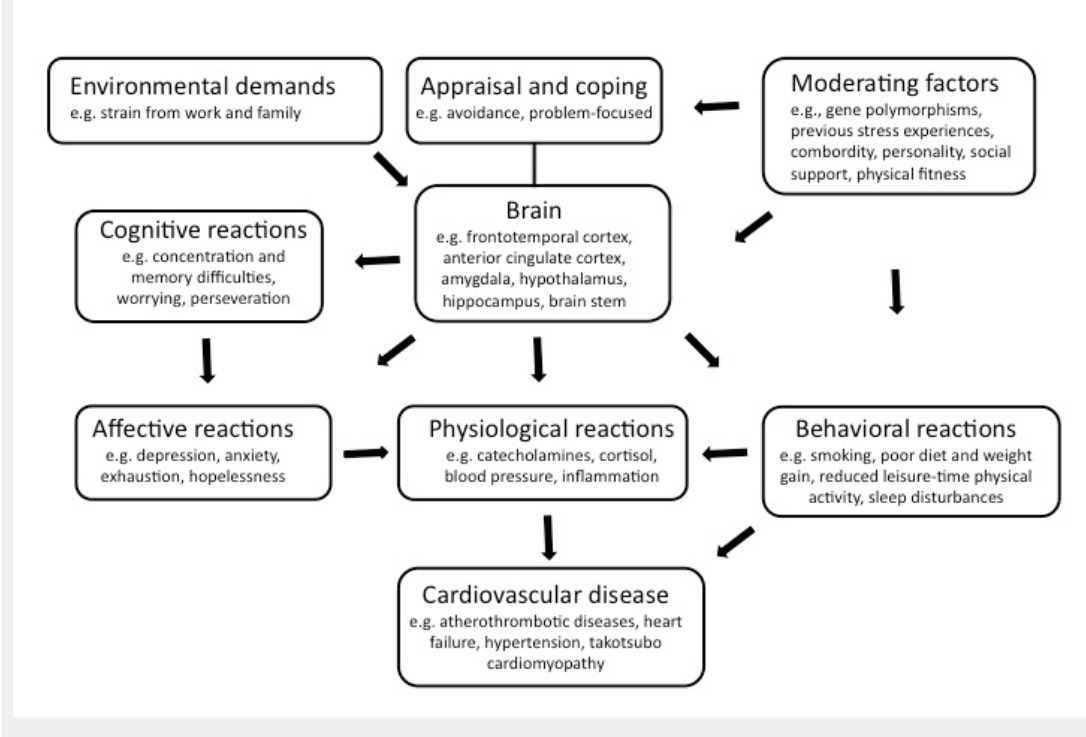
Depending on appraisal, coping resources, and several moderating factors, environmental demands trigger a neurobiologically driven stress reaction across cognitive, affective, behavioural, and physiological domains, all contributing directly and/or indirectly to cardiovascular